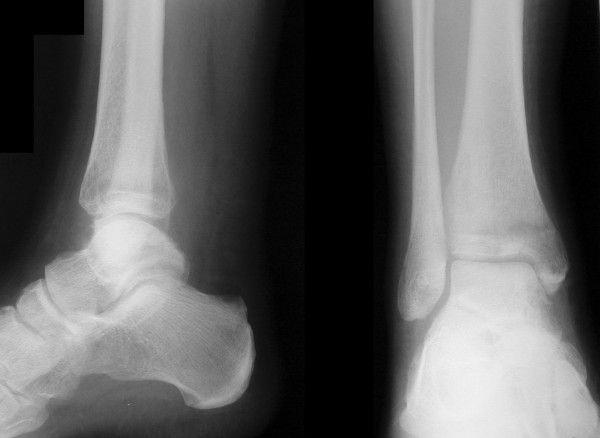
Radiograph of the ankle at presentation: an undisplaced fracture of the medial malleolus is evident.